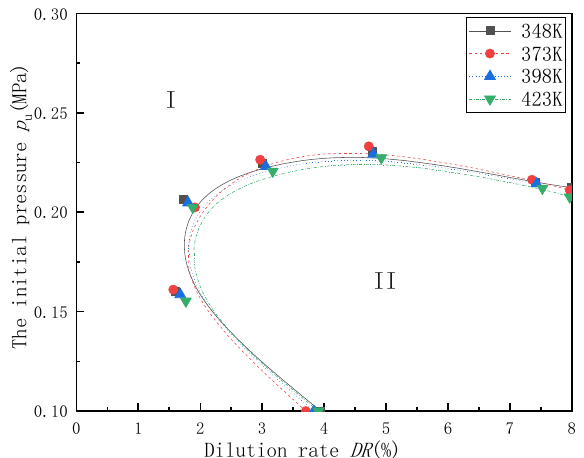
Figure 16. Variation pattern of the equal weight curve corresponding to Tu with ∆DR = 2% and ∆P = 0.05 MPa.